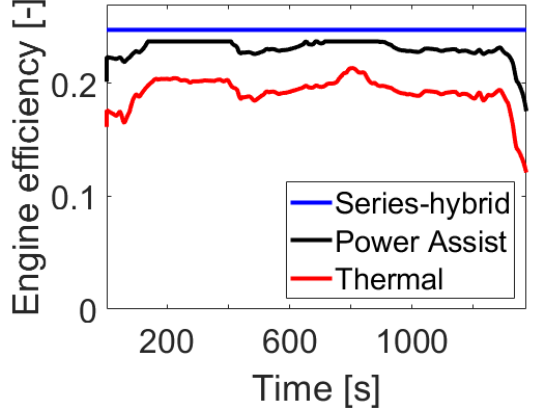
Figure 10. Engine e ffi ciency for the series -hybrid, power assist, and thermal modes.